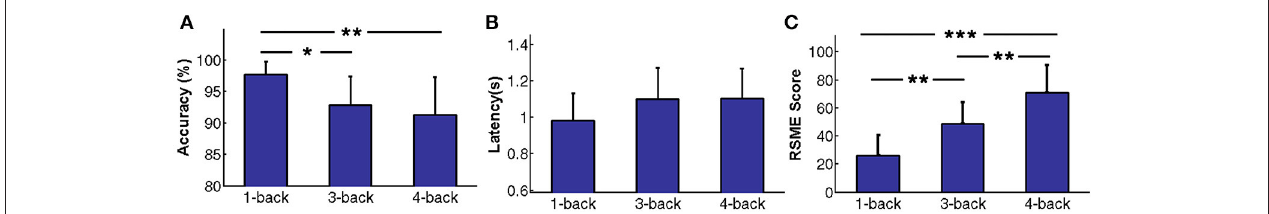
FIGURE 2 | Behavior performance and RSME scores for n-back tasks . (A) Response accuracy. (B) Response latency. (C) RSME scores. The error bars represent standard deviations across subjects and asterisks represent significant differences between two n-back tasks (* p < 0.05, ** p < 0.01, *** p <